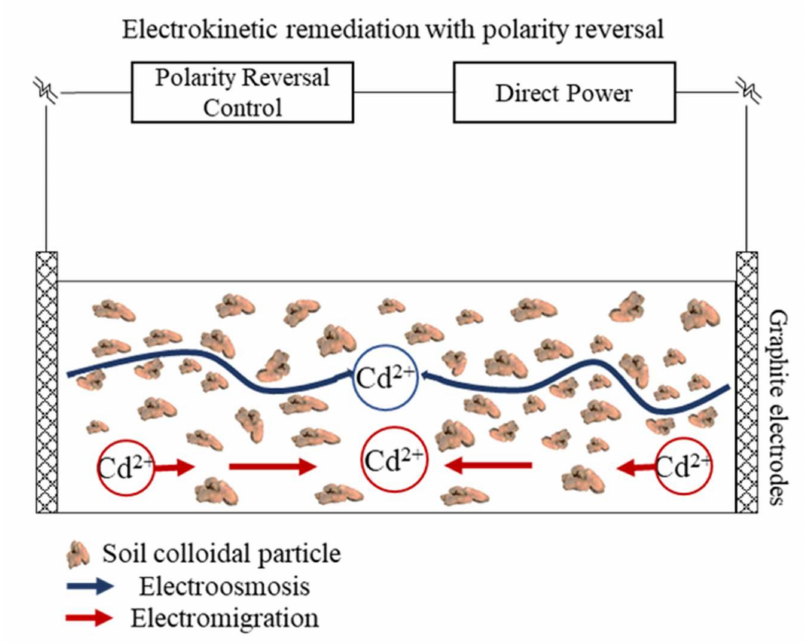
Figure 6. Transport mechanisms of Cd contaminants in the soil under EKR with polarity